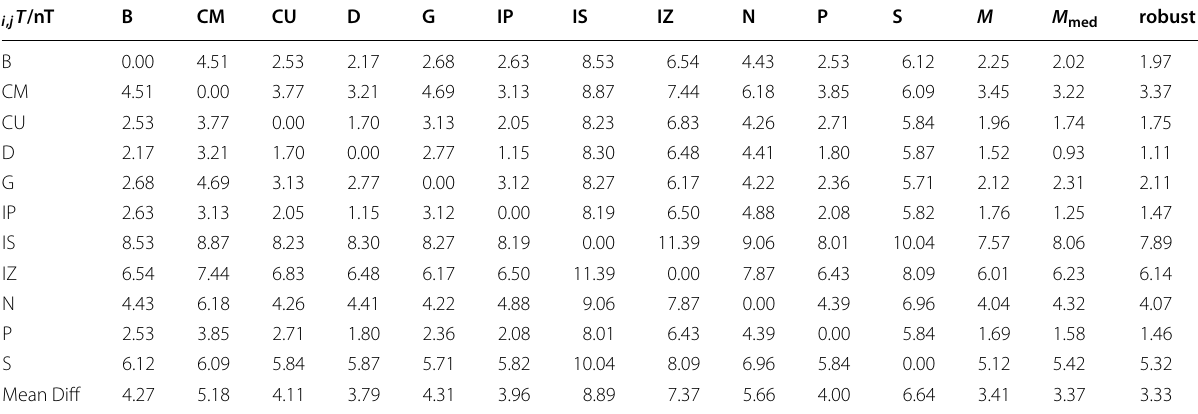
The bottom row is the simple arithmetic mean of the columns